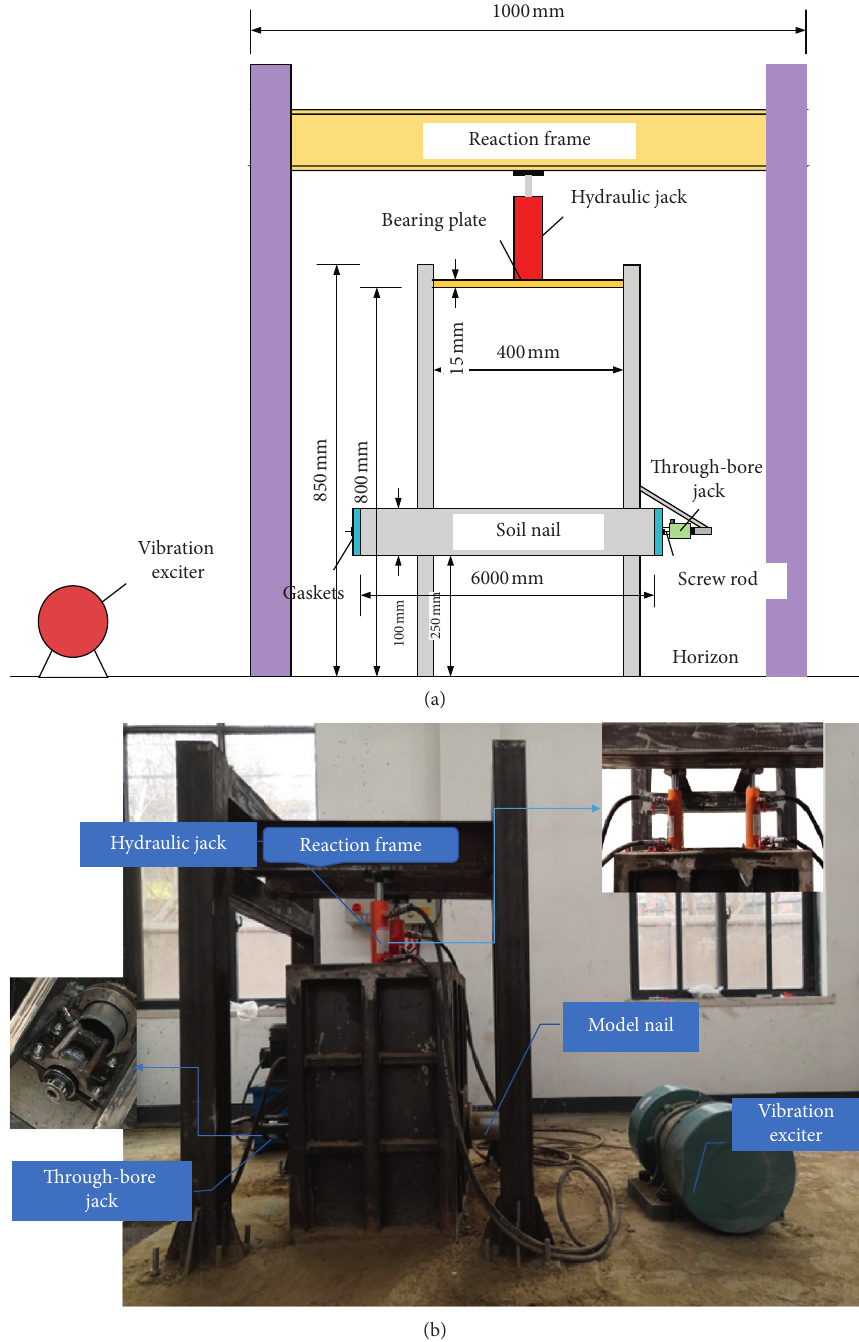
Figure 6: Layout of model test. (a) Schematic diagram. (b) Test